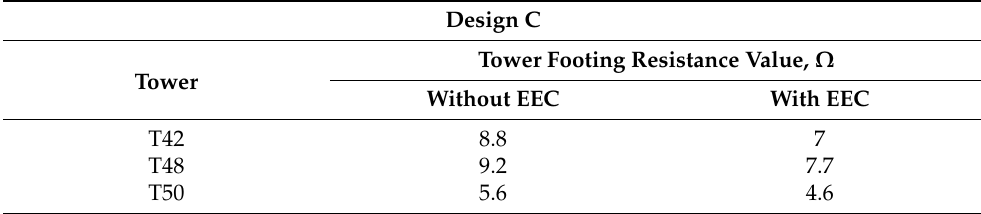
Table 6. TFR analysis of Design C encased with EEC.